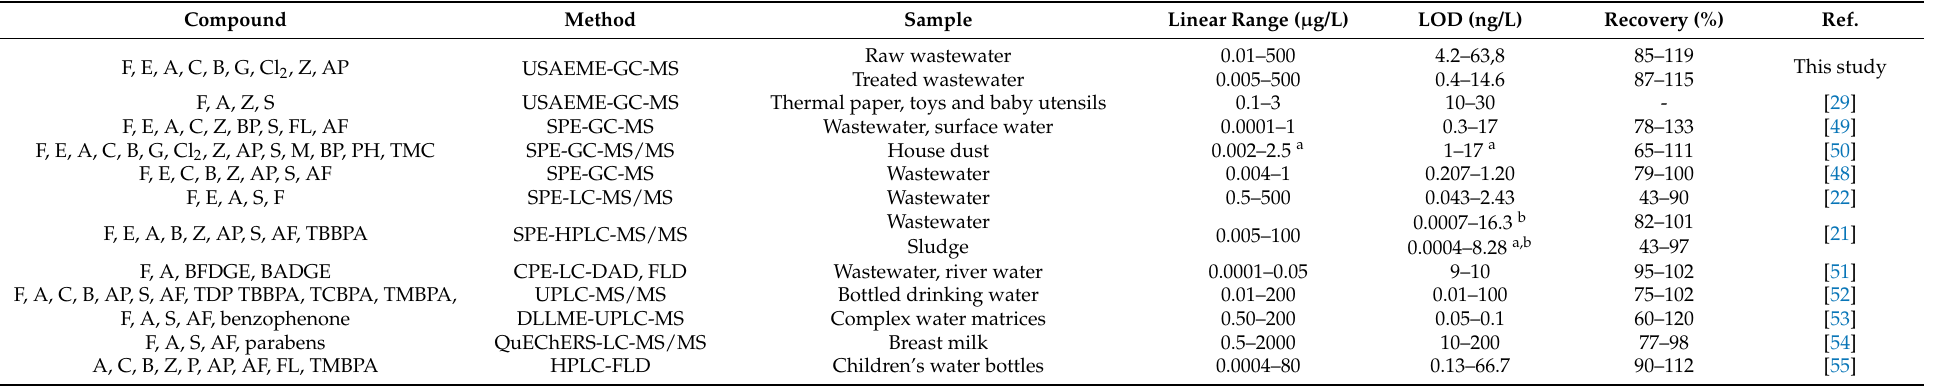
Table 8. Comparison of the validation parameters of the proposed method with literature